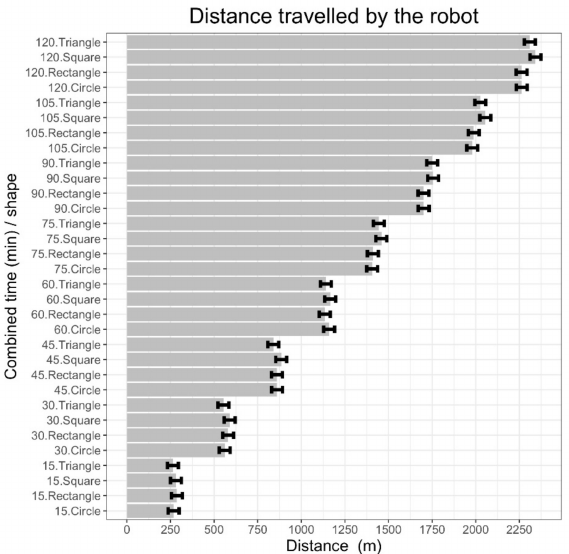
Figure 6. Means and 95% confidence intervals of the distance travelled by the robot mower in the four turfgrass areas (square, rectangle, triangle, and circle) at 15, 30, 45, 60, 75, 90, 105, and 120 min after the start of